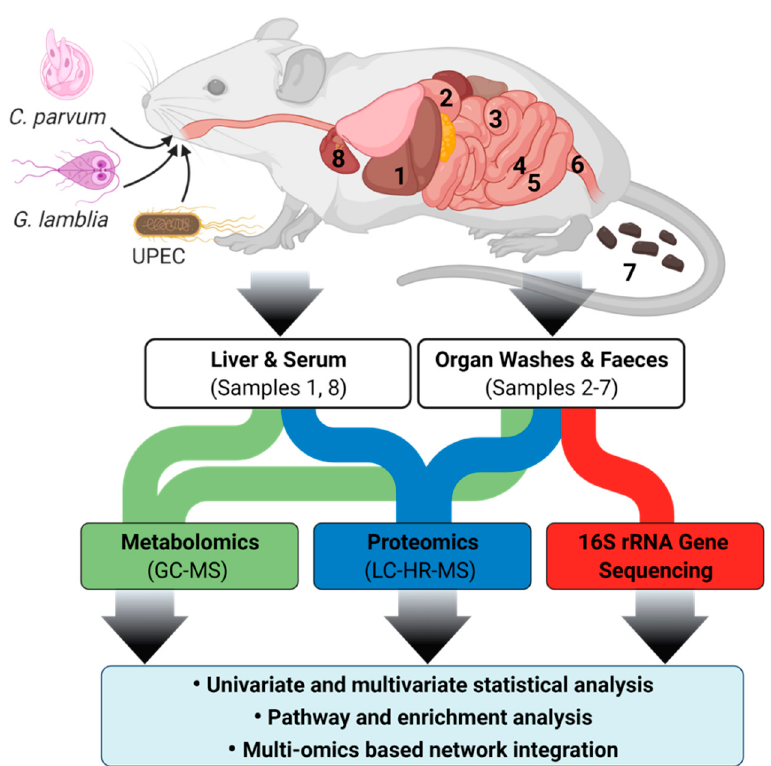
Figure 8. Overview of mouse cryptosporidiosis interaction study design showing various mouse samples that were collected. Samples were subjected to GC-MS and LC-HR-MS and resulting data were analysed by multivariate statistics. Samples are annotated as (1) liver tissue, washes of (2) duodenum, (3) jejunum, (4) ileum, (5) caecum, (6) colon, (7) faeces, and (8) serum.